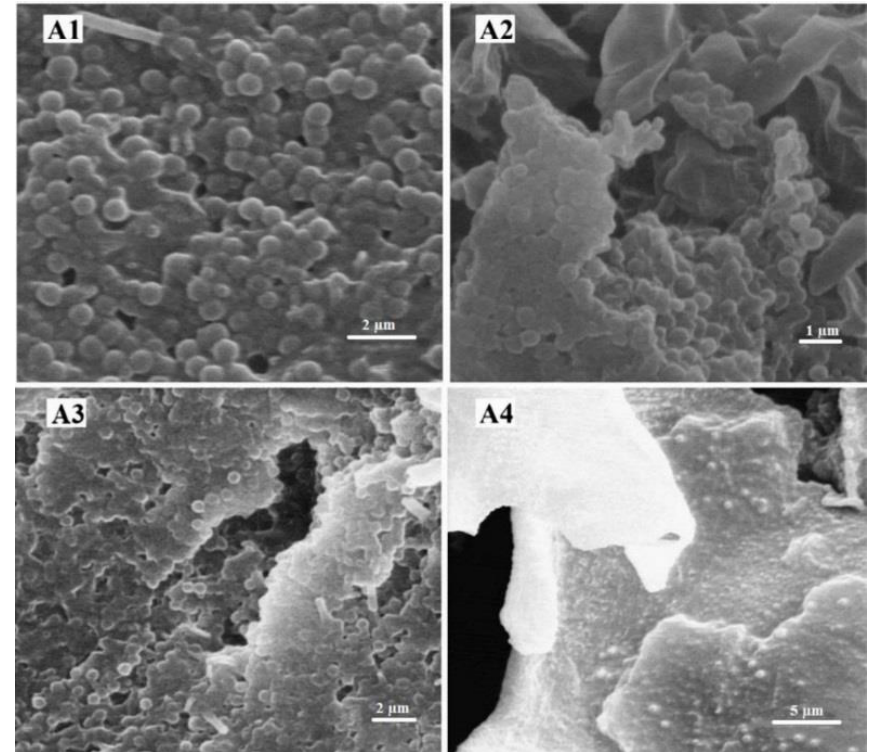
Figure 1. SEM images of the four different batches of cisplatin-loaded PBCA NPs. ( A1 ) (0.25% w / v PEG concentration, room temperature), ( A2 ) (0.25% w / v PEG concentration, 65 °C), ( A3 ) (1.0% w / v PEG concentration, room temperature), and ( A4 ) (1.0% w / v PEG concentration, 65 °C).